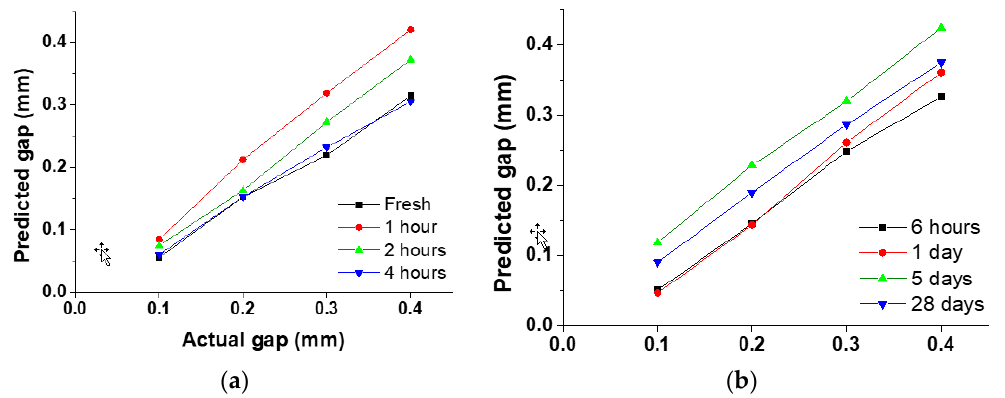
Figure 8. Predicted gap vs. actual gap between steel plate and concrete at ( a ) 0, 1, 2 and 4 h; and ( b ) 6 h, 1 day, 5 days and 28 days of concrete casting.